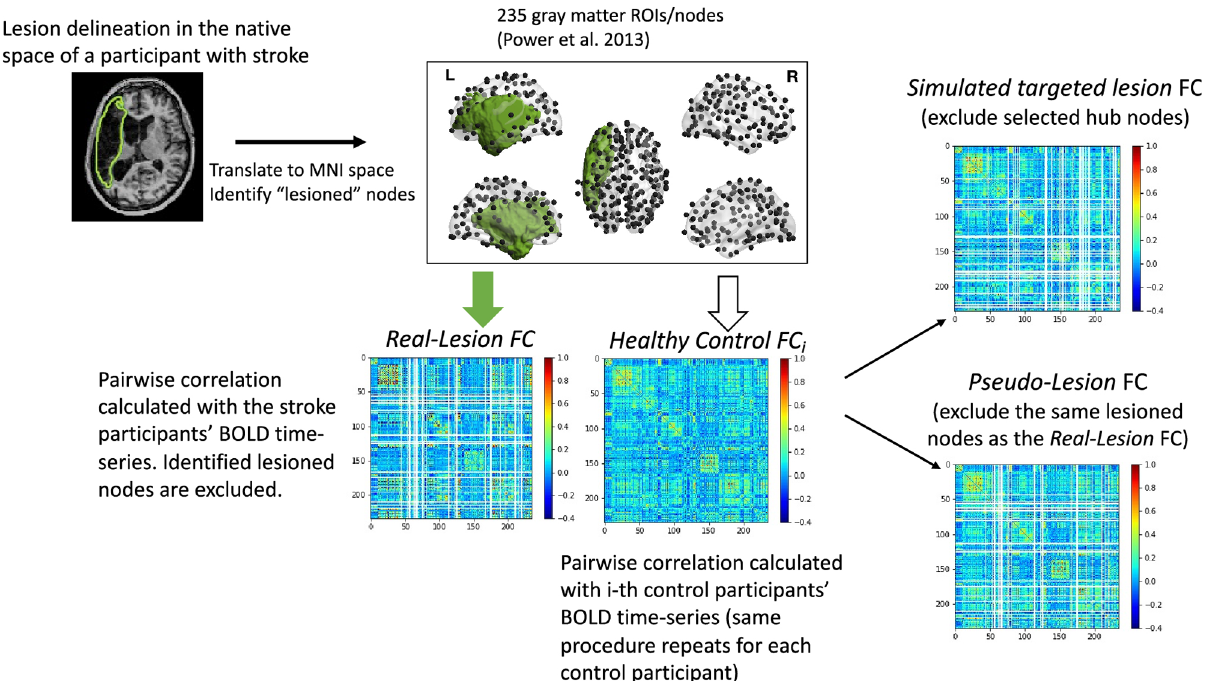
Figure 4. Procedures for generating Real-Lesion, Pseudo-Lesion, and Simulated Targeted-Lesion functional connectomes (FC). For each participant, their functional connectome was calculated based on 235 gray matter ROIs (10 mm-radius spheres), resulting in a 235-by-235 pairwise Pearson correlation matrix (see “Functional connectivity estimation”). Real-Lesion FC (bottom-left): for each participant, a lesion mask was first manually drawn on the structural image, then the lesion mask was co-registered to the MNI standard space to identify the “lesioned nodes” (see “Preprocessing” and “Analysis 2: Comparison of pseudo and real lesions: modularity, PC and WD”) and, the correlation values of the lesioned nodes (rows and columns of the matrix, marked as blank in the figure) were excluded from subsequent analyses. Pseudo-Lesion FC (bottom center): for each healthy control’s connectome, correlation values corresponding to the “lesioned nodes” were excluded from subsequent analyses. The FC from one healthy control is depicted in which the same rows and columns as in the Real- Lesion FC are left blank. Simulated Targeted-Lesion FC (bottom right): for each healthy control’s connectome, correlation values of the identified global/local hub nodes (Fig. 8a) were excluded from subsequent